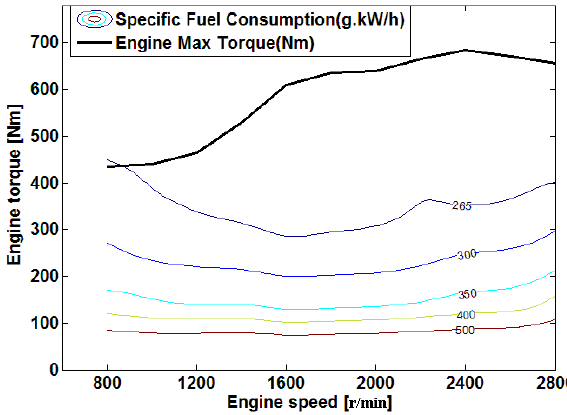
Figure 2. Fuel consumption contour map of engine.